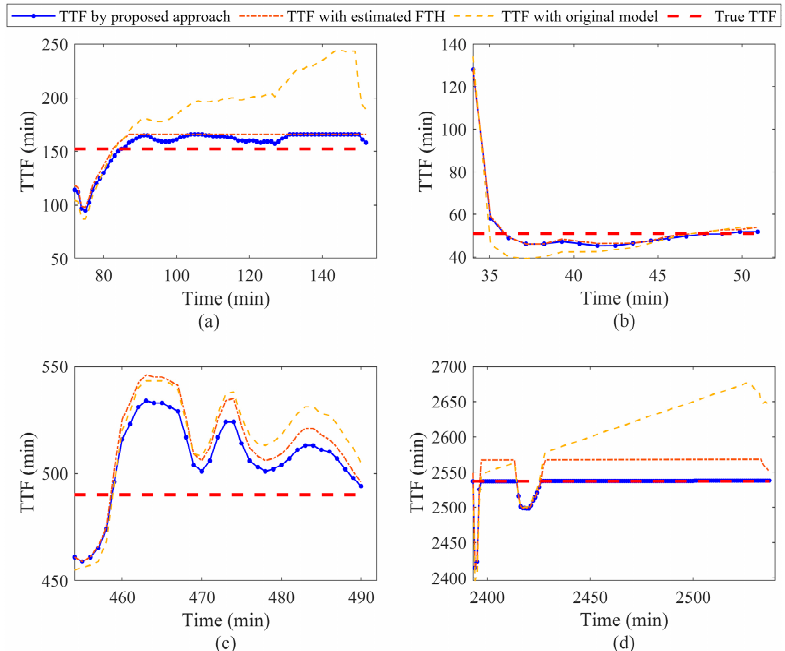
Figure 8. TTF prognostic results of the tested bearings ( a ) bearing 1_3, ( b ) bearing 1_5, ( c ) bearing 2_1, and ( d ) bearing 3_1 using an original method (without FTH estimation and DT detection), the method with FTH estimation, and the proposed method.